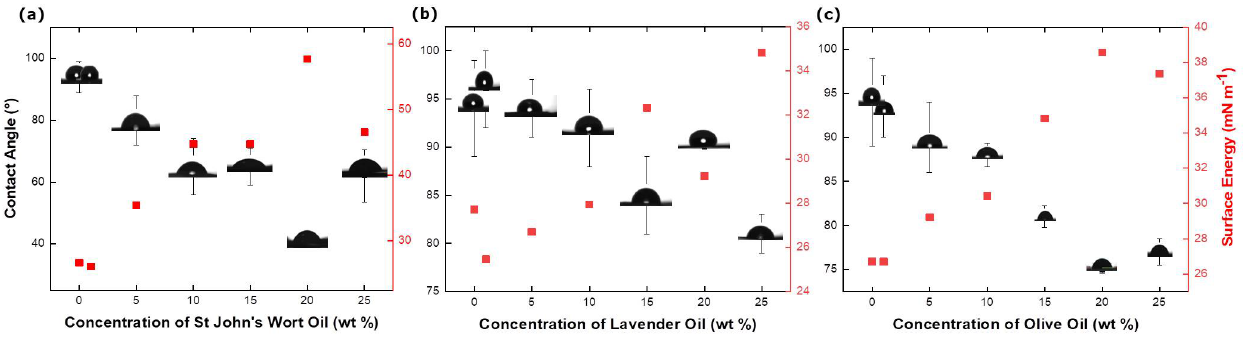
Figure 6. Contact angle and surface energy values of ( a ) TPU/SJWO fibers, ( b ) TPU/LO fibers, and ( c ) TPU/OO fibers (applied voltage: 12.5 kV, flow rate: 1.00 mL h − 1 , distance: 17 cm, and TPU concentration in the solutions: 12.5 wt %).